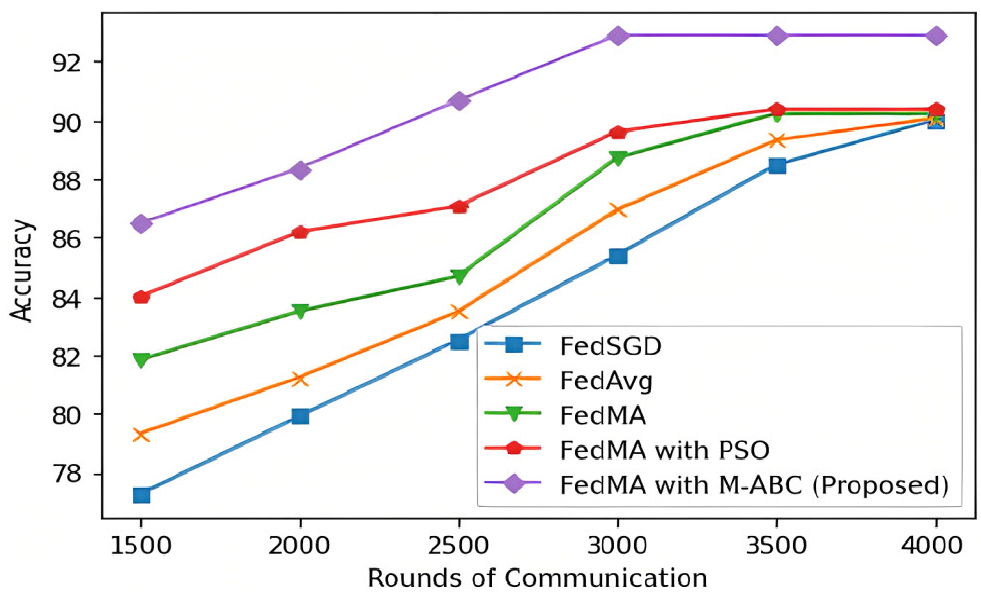
Figure 2. Comparison of communication efficiency.